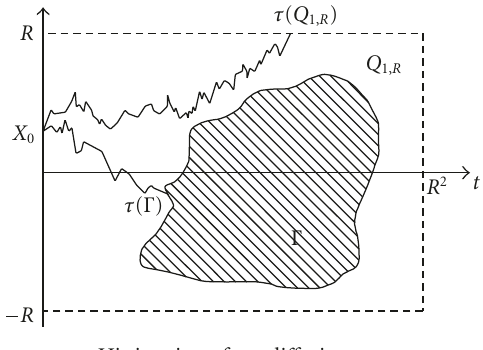
Figure 3.1. Hitting times for a di ff usion (figure courtesy of R. Husseini, SFB 611,